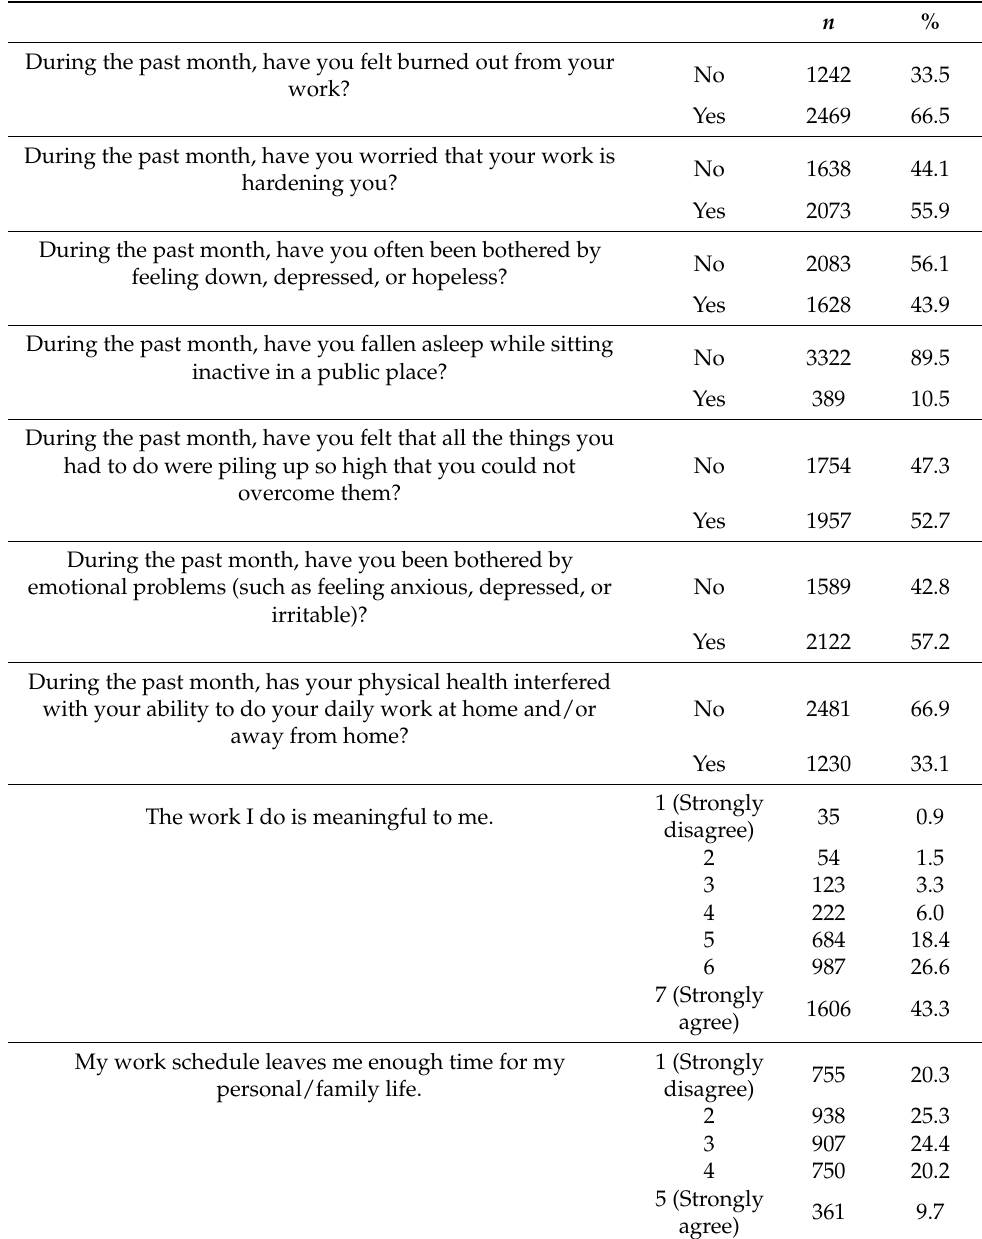
Table 3. GPs’ eWBI components and total scores during the COVID-19 pandemic ( n = 3711).